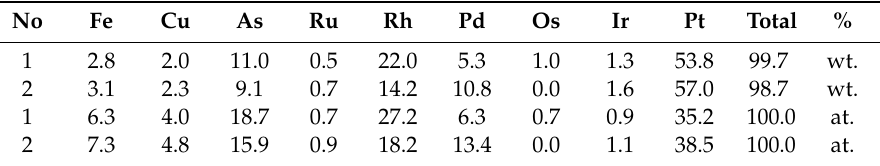
Table 4. The result of determining the composition of emulsion inclusions of rhodarsenide in grain No. 1, according to SEM-EDS